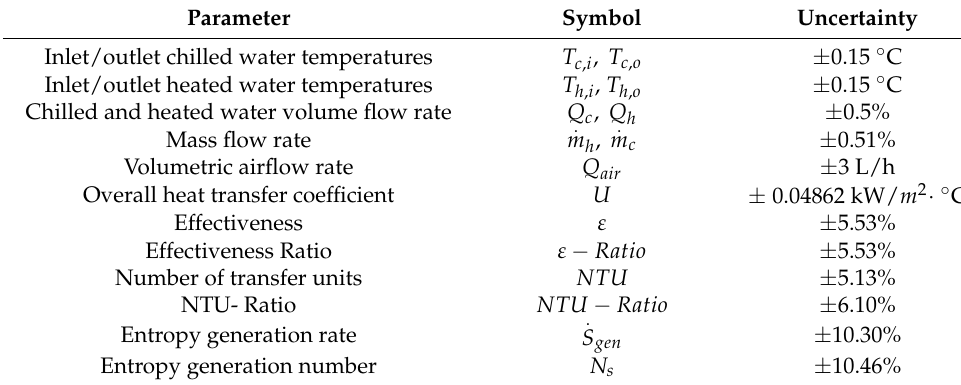
Table 2. Computed parameters